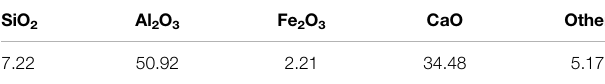
TABLE 1 | Chemical composition of high-alumina cement (by mass)/%. TABLE 2 | Basic physical properties of high-alumina